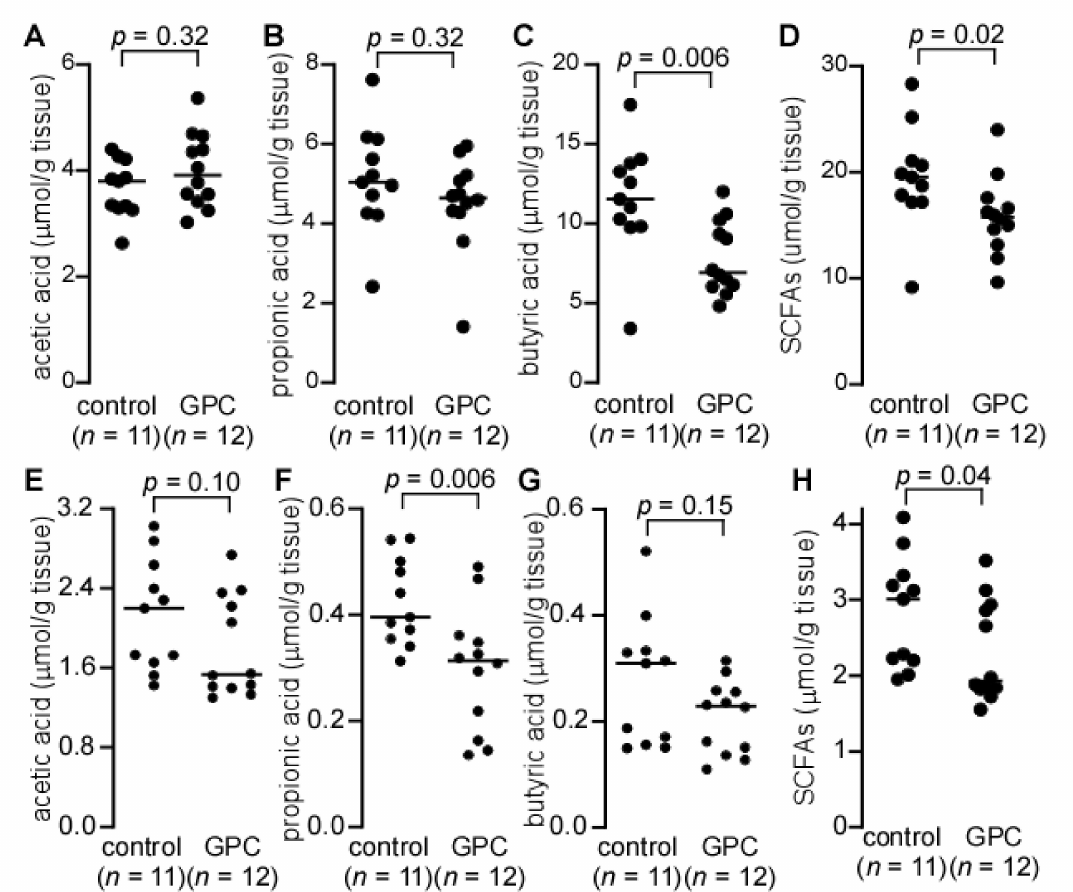
Figure 7. Cecal and fecal short chain fatty acids (SCFAs) in LDLr − / − mice fed GPC supplemented or control chow diet. ( A – D ) LDLr − / − mice were fed GPC supplemented chow diet or control chow diet for one month and cecum was collected to quantify SCFAs. ( E – H ) LDLr − / − mice were fed GPC supplemented chow diet or control chow diet for three weeks, and feces was collected to quantify SCFAs. Cecum and feces were homogenized in water with isotope labeled SCFAs, [ 13 C 2 ] acetic acid, [ 13 C 3 ] propionic acid, and [ 13 C 4 ] butyric acid added as internal standards. The filtrate was used to quantify SCFAs after derivatization by LC-MS. p values were calculated by Wilcoxon rank sum test. Panels ( D , H ) display total SCFAs, which is the sum of acetic acid, propionic acid, and butyric acid, from panels ( A – C ) and ( E – G ),